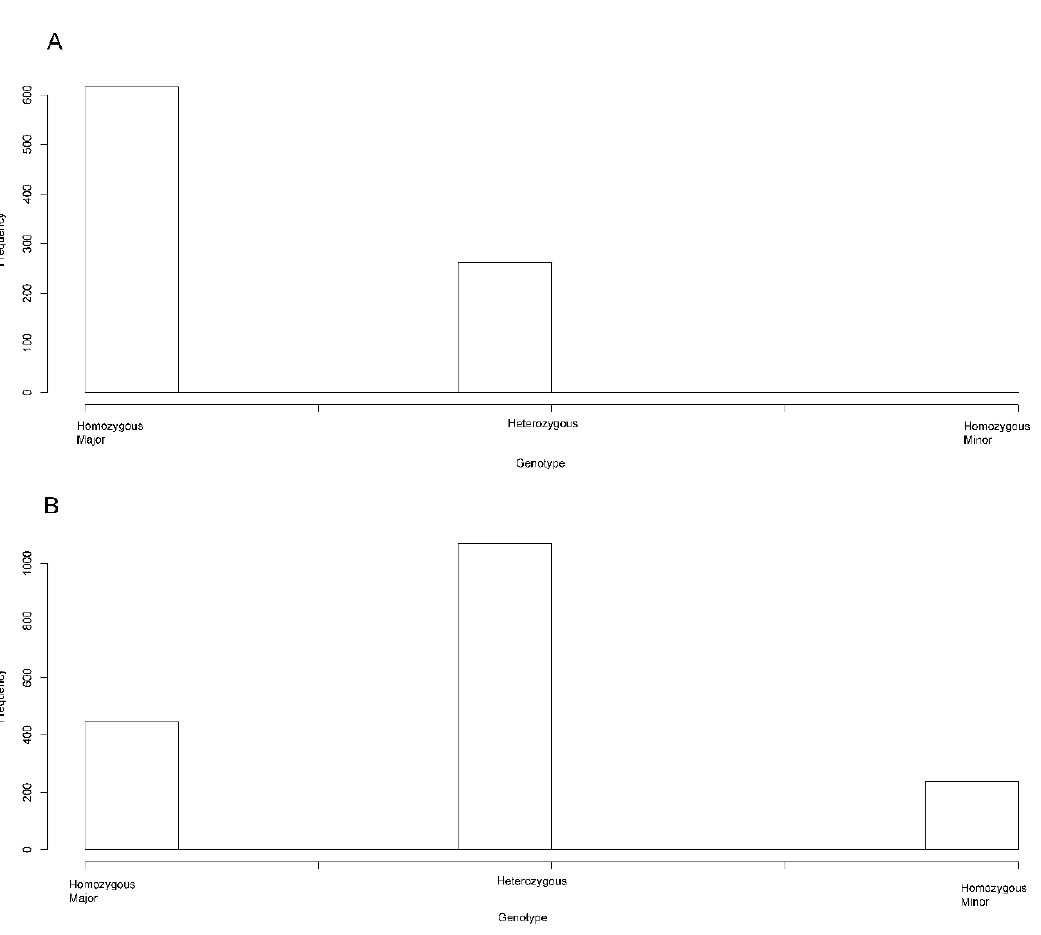
Figure 5. Histograms of the children ( A ) and parents ( B ) of the genotypes of the genome-wide significant chromosome 20 variants in 20 trios. The frequencies of the homozygous major, heterozy- gous, and homozygous minor genotypes for the 44 associated variants (rs6127972 not included) are displayed as bar